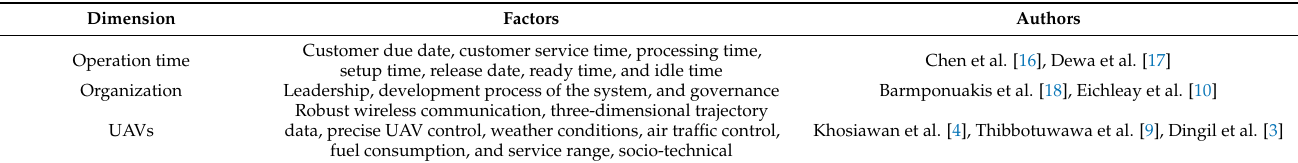
Table 2. The considered factors of TSP and